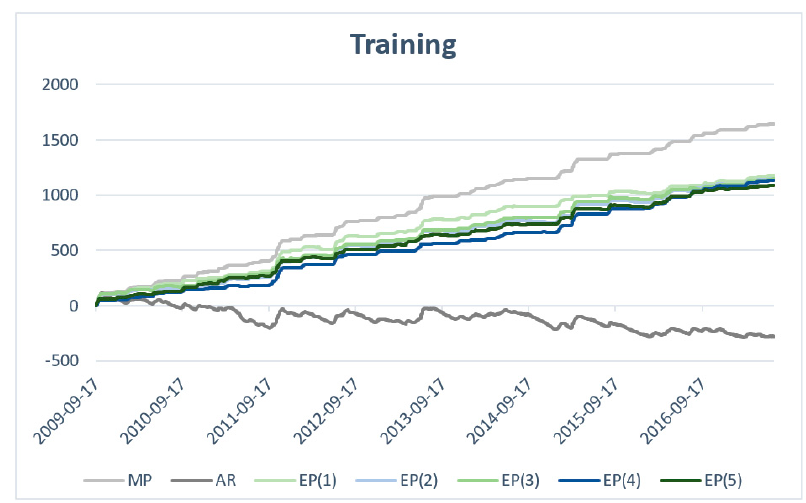
Figure 7. Development of the MP and AR indicators in the training set and of the EP indicator for the top five SANNs from the training set (in USD/b).